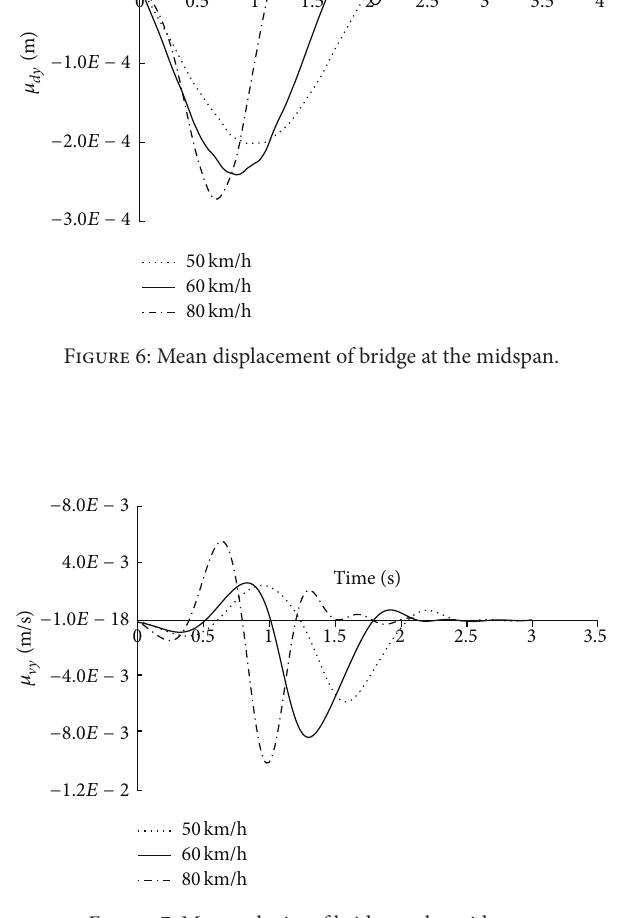
Figure 7: Mean velocity of bridge at the midspan.